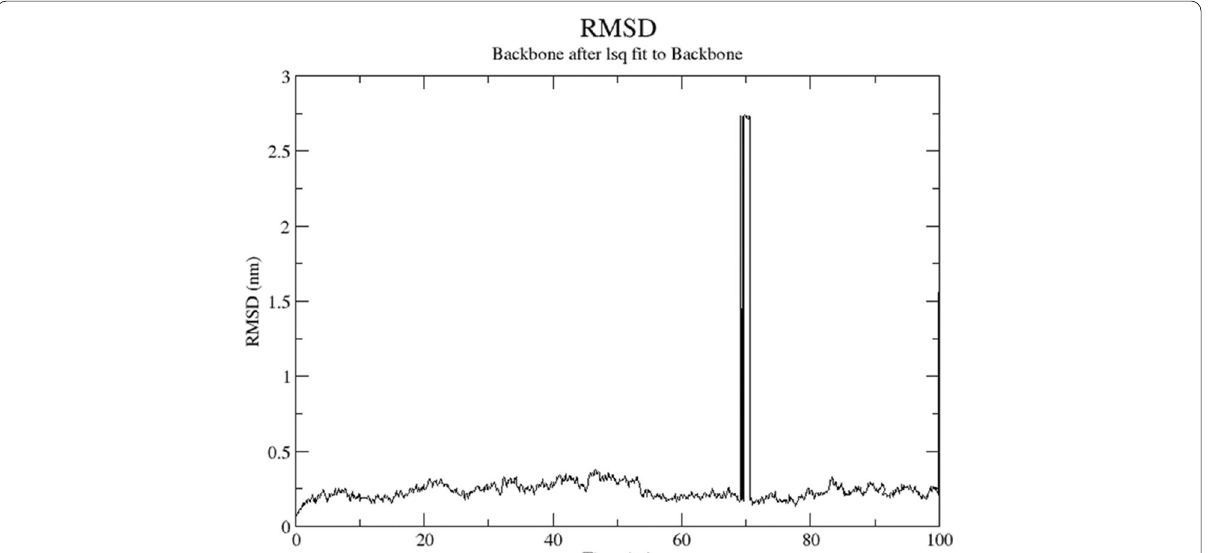
Fig. 6 RMSD values of the docked complex of TLR5A (PDB: 3JOA) and the designed construct during molecular simulation analysis at the 100‑ns time scale